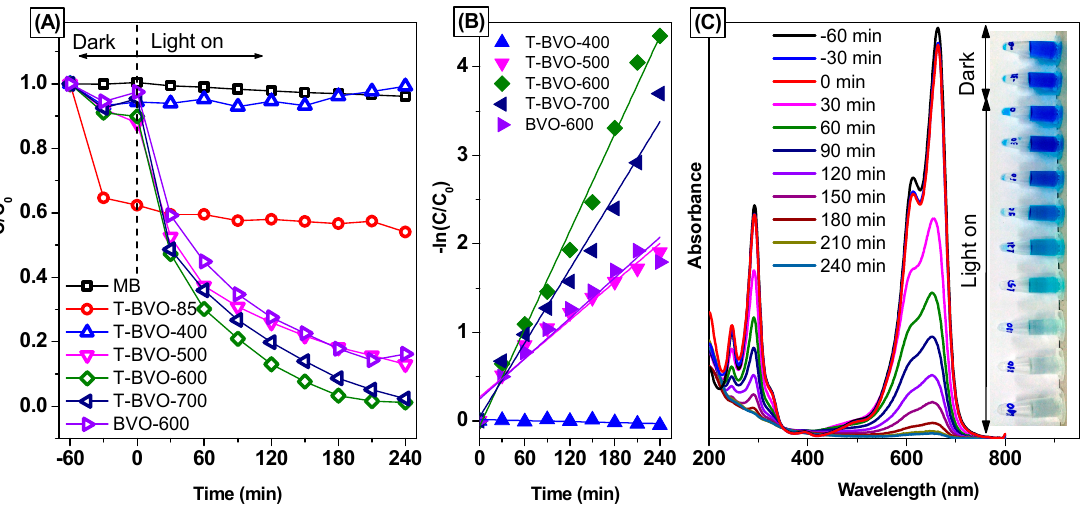
Figure 8. Photocatalytic degradation of methylene blue (MB) over BiVO 4 samples ( A ), plots of ln(C o /C) versus irradiation time representing the fit using a pseudo-first-order reaction rate ( B ), and UV-vis absorption spectra of MB solution separated from catalyst suspensions during illumination using T-BVO-600, ( C ). Insert displays a digital photo of photodegradation for MB after different illumination times.